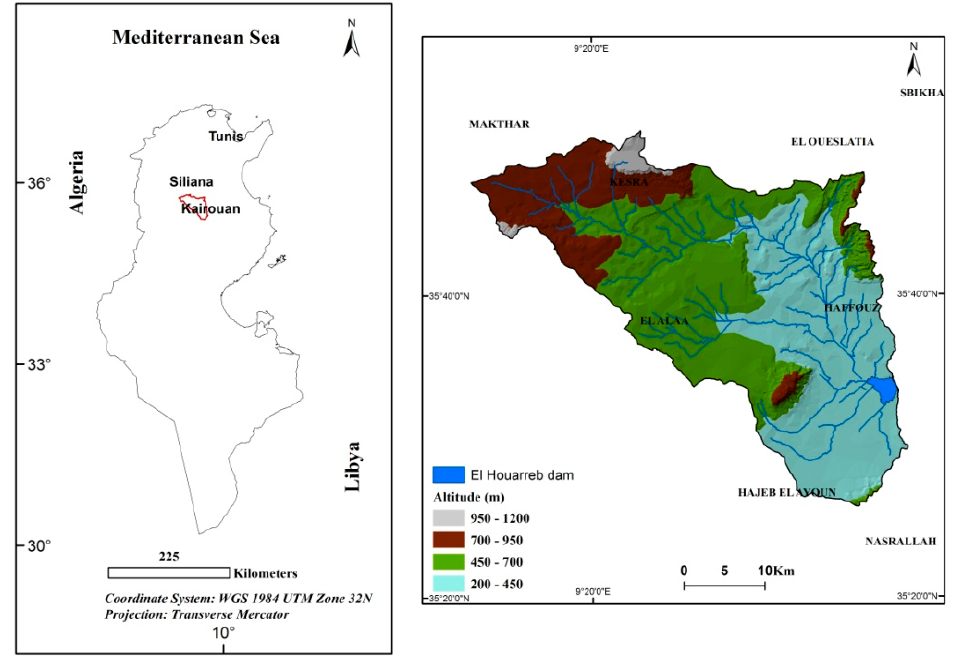
Figure 1. Location and topography of the experimental Merguellil Wadi Basin.